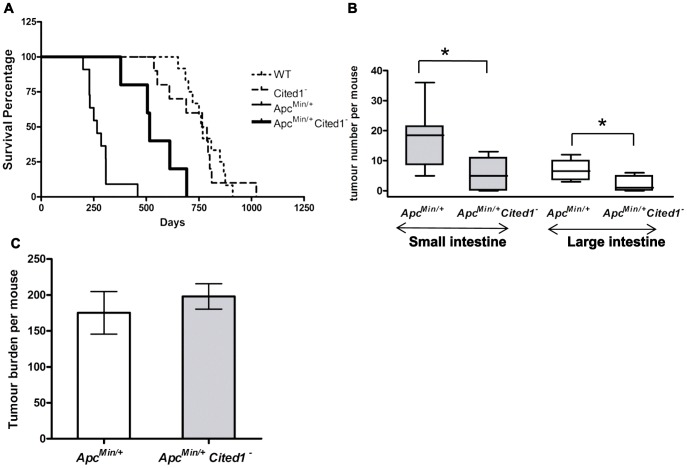
Loss of Cited1 extends lifespan of ApcMin/+ mice and reduces the number of intestinal adenomas.
A:
 Kaplan-Meier plot of survival of ApcMin/+ (thin continuous line), ApcMin/+Cited1− mice (thick continuous line), Cited1− (dashed line) and WT (dotted line). The median lifespan of ApcMin/+ mice cohort was 230.5 days (n = 8), which was increased to 515 days in ApcMin/+Cited1
− mice (n = 5) (p = 0.001 Log-Rank test). The median lifespan of Cited1− was 766 days (n = 10) and is similar to WT with a lifespan of 760 days (n = 12) (p = 0.749 Log-Rank test). B: In both small intestine (grey boxes) and large intestine (blank boxes), tumour numbers were reduced in ApcMin/+Cited1− mice (n = 5) compared to ApcMin/+ mice (n = 8) (*p<0.05, Mann-Whitney U test). C: Tumour burden was calculated and represent the total tumour volume per mouse. There is no significant difference between ApcMin/+ (white) and ApcMin/+Cited1− (Grey) (p>0.05, Mann-Whitney U test).